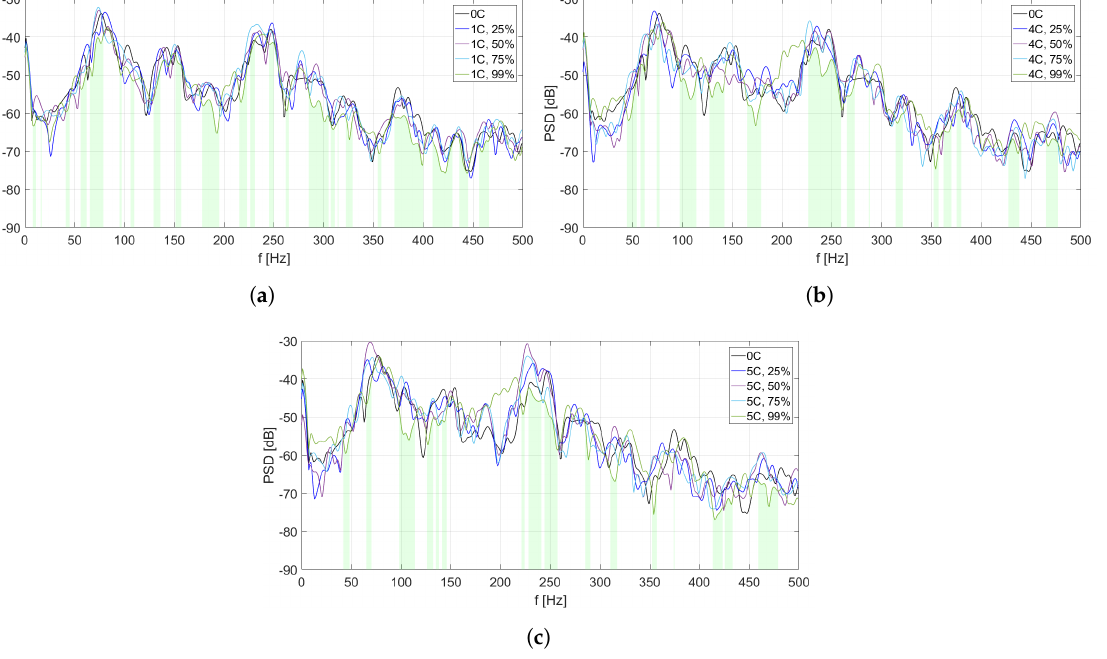
Figure 9. PSD estimates of MFC4 input signals: ( a ) scenario of one coupling activated, ( b ) scenario of four couplings activated, ( c ) scenario of five couplings